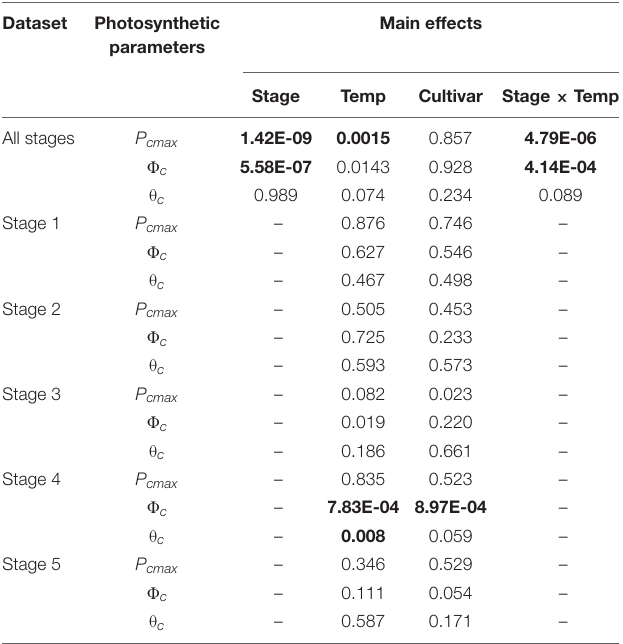
TABLE 2 | Statistical analysis of the significance of factors controlling canopy photosynthetic parameters ( P cmax , (cid:56) c , θ c ) derived from light response curve of canopy photosynthesis (A cr